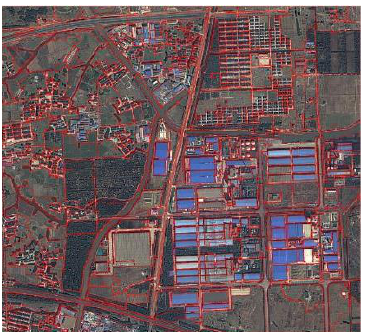
Figure 4. Segmentation Results of Two Overlapping Images